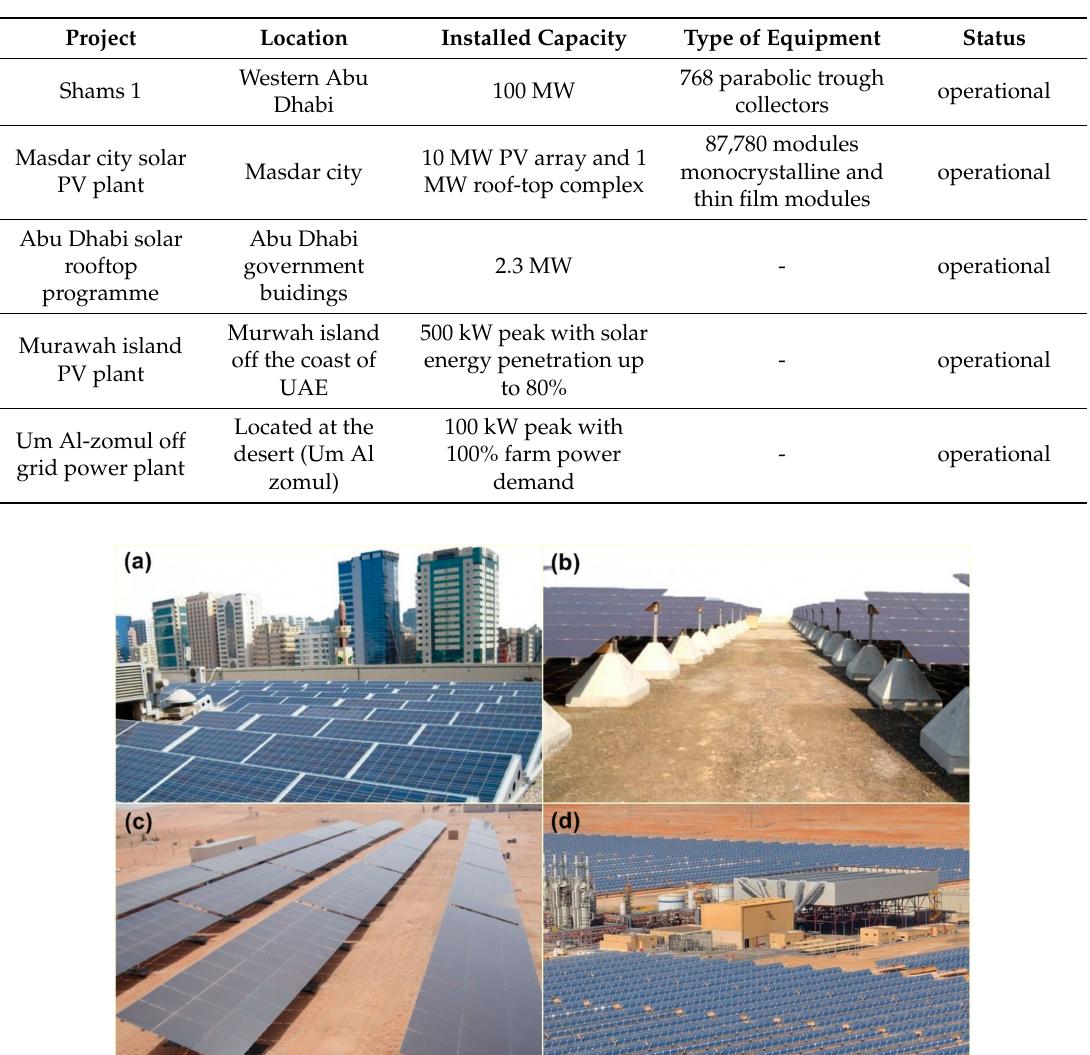
Figure 5. Solar projects in UAE: ( a ) Abu Dhabi solar rooftop; ( b ) Murawah Island PV Plant; ( c ) Um Al Zomul off-grid PV plant; and ( d ) Shams 1. Adapted from